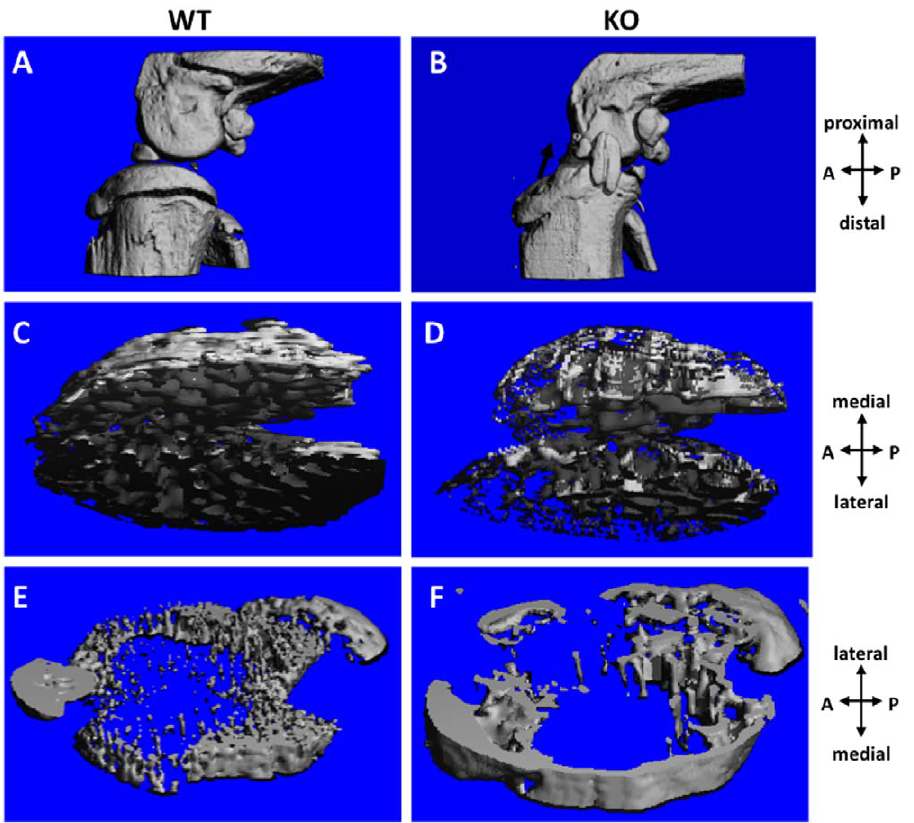
Figure 3. MicroCT images of 2-month-old mouse knees, showing the calcified structures of the right knees of a male wild-type mouse (left images: A, C, E) and a male Col6a1 2 / 2 mouse (right images: B, D, F). Top row (A, B) shows a medial view of the knee; note the ossified medial collateral ligament in the Col6a1 2 / 2 joint (arrow, B). Middle row (C, D) displays a distal view of the tibial trabecular bone, where the Col6a1 2 / 2 trabeculae are rod-like while the wild-type trabeculae are plate-like. Bottom row (E, F) shows a proximal view of the tibial metaphyseal region, where the wild-type bone is immature in comparison to the Col6a1 2 / 2 bone. WT= Col6a1 + / + ; KO= Col6a1 2 / 2 .